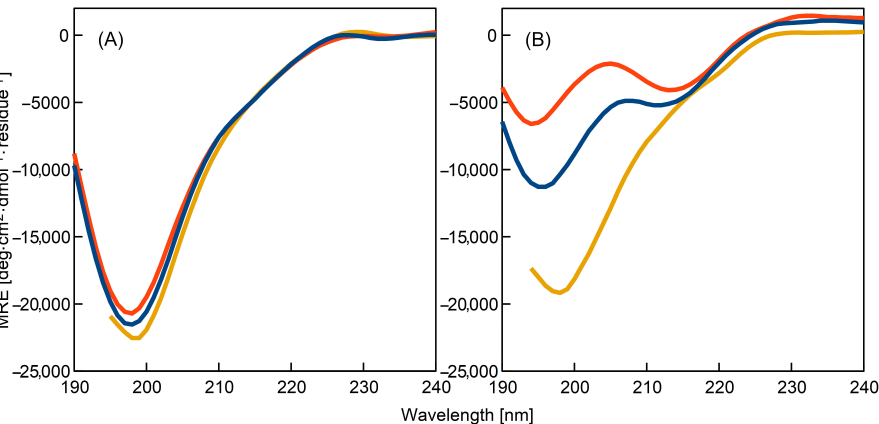
Figure 4. Mean residue ellipticity (MRE) recorded for: ( A ) samples of non-incubated freshly prepared solutions of the K-peptide, ( B ) samples of the K-peptide incubated at 37 ◦ C for 14 days. The peptide was dissolved in: water (blue line); acetate buffer, pH = 4, without additives (red line) and acetate buffer with urea (dark yellow line).